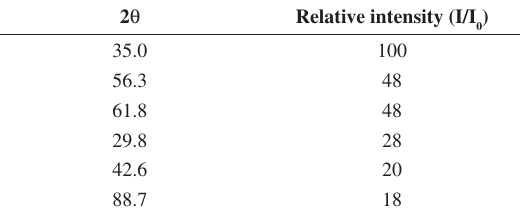
Figure 3. XRD pattern of the Mn Table 1. Typical peaks related to the MnZn phase formation.